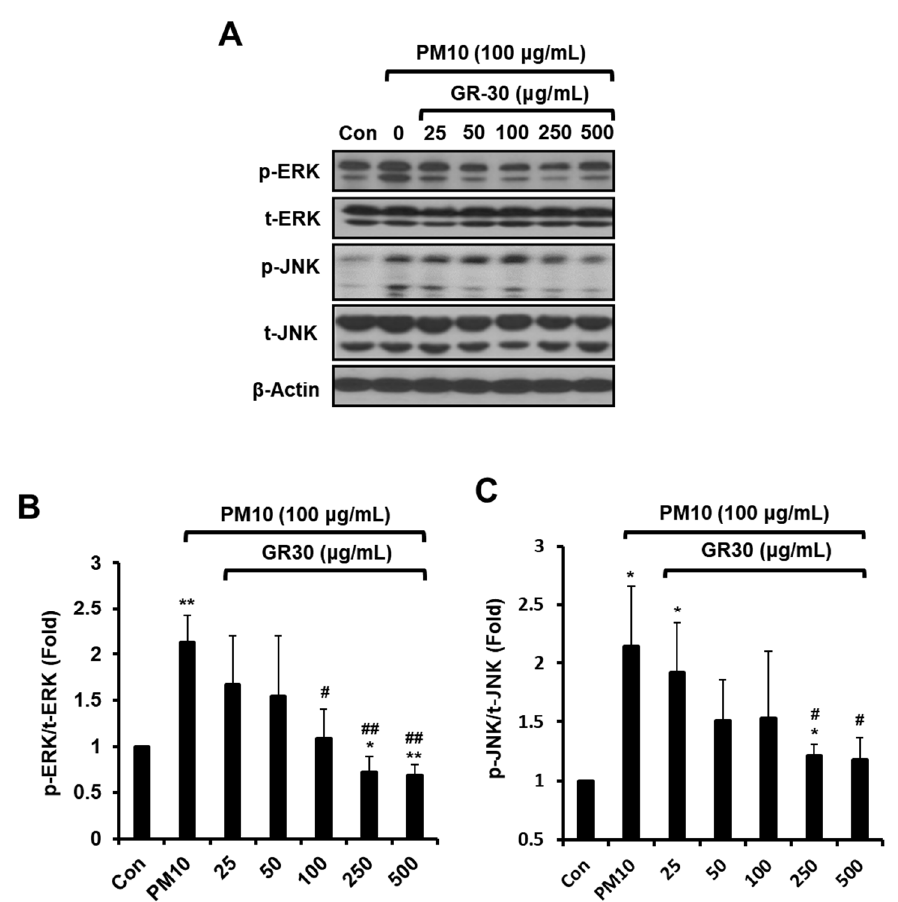
Figure 5. GR30 downregulates the PM10-induced MAPK pathway activation. ( A ) The phosphorylation of MAPK in RBL-2H3 cells was evaluated by Western blot assay. Total ERK (t-ERK) and total p38 (t-JNK) were used as loading controls for phosphorylated ERK ( p -ERK) and phosphorylated p -JNK ( p -JNK), respectively. The levels of ( B ) p -ERK and ( C ) p -JNK were quantified by densitometric analysis and expressed as the ratios of the phosphorylated proteins to the corresponding total protein. Each value was presented as the means ± SD ( n = 3). *, p < 0.05; **, p < 0.01, compared to the control cells (Con). #, p < 0.05; ##, p < 0.01, compared to the PM10 ‐ treated cells (PM10).